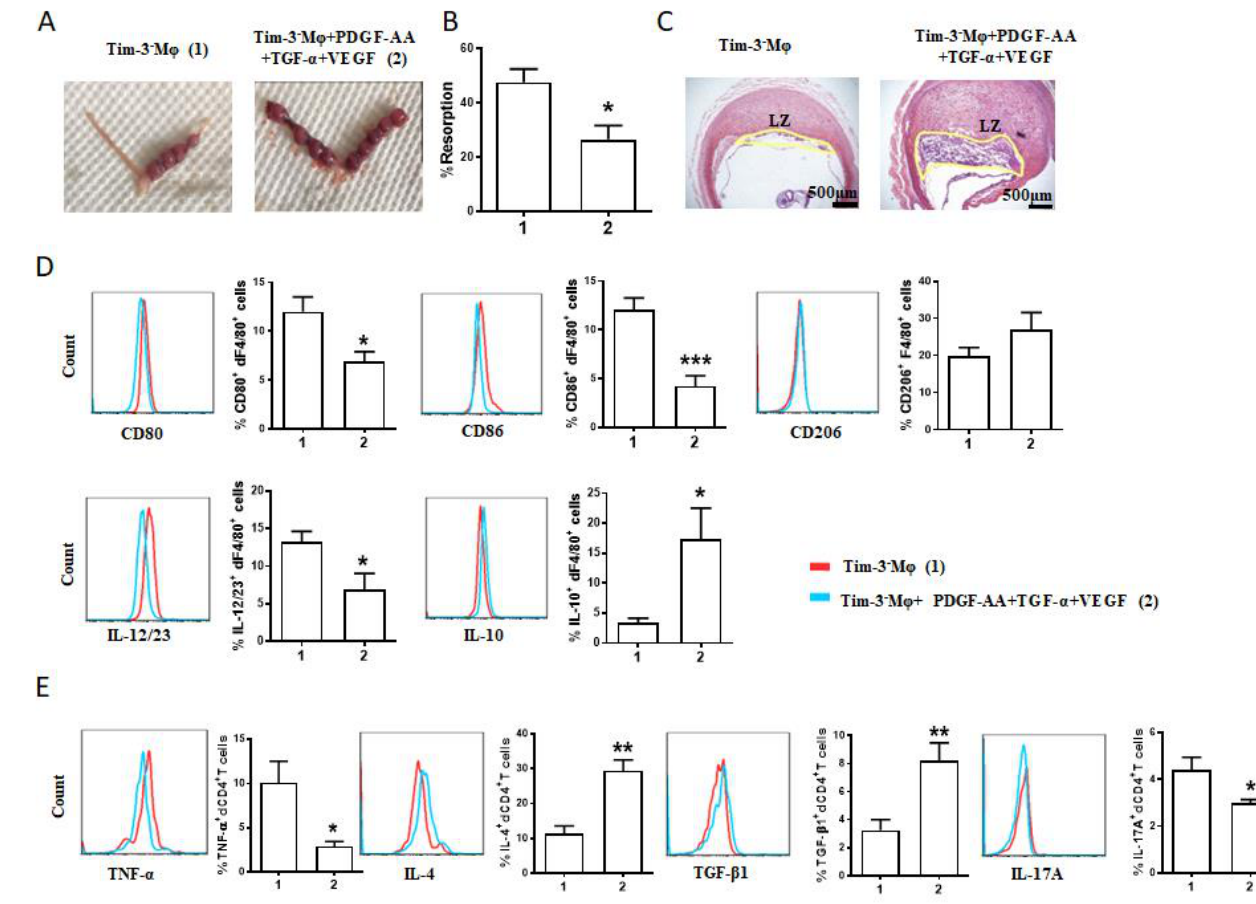
Figure 6. AGFs-treated Tim-3 - Mφs also alleviated murine fetal loss resulting from Mφ depletion. ( A – C ) Representative images of uterus ( A ), statistics of the percentage of fetal resorption ( B ), and placental hemisections (H&E-stained) ( C ) of pregnant mice after Mφ depletion and adoptive transfer of indicated Tim-3 - Mφs. ( D ) Representative images of flow cytometry and quantifications of surface molecule and cytokine expression on dMφs from pregnant mice after Mφ depletion and adoptive transfer. ( E ) Cytokine expression of dCD4 + T cells from pregnant mice after Mφ depletion and the indicated adoptive transfer. Data represent mean ± SEM ( n = 4 – 8). * p < 0.05, ** p < 0.01, *** p < 0.001, compared with group 1.